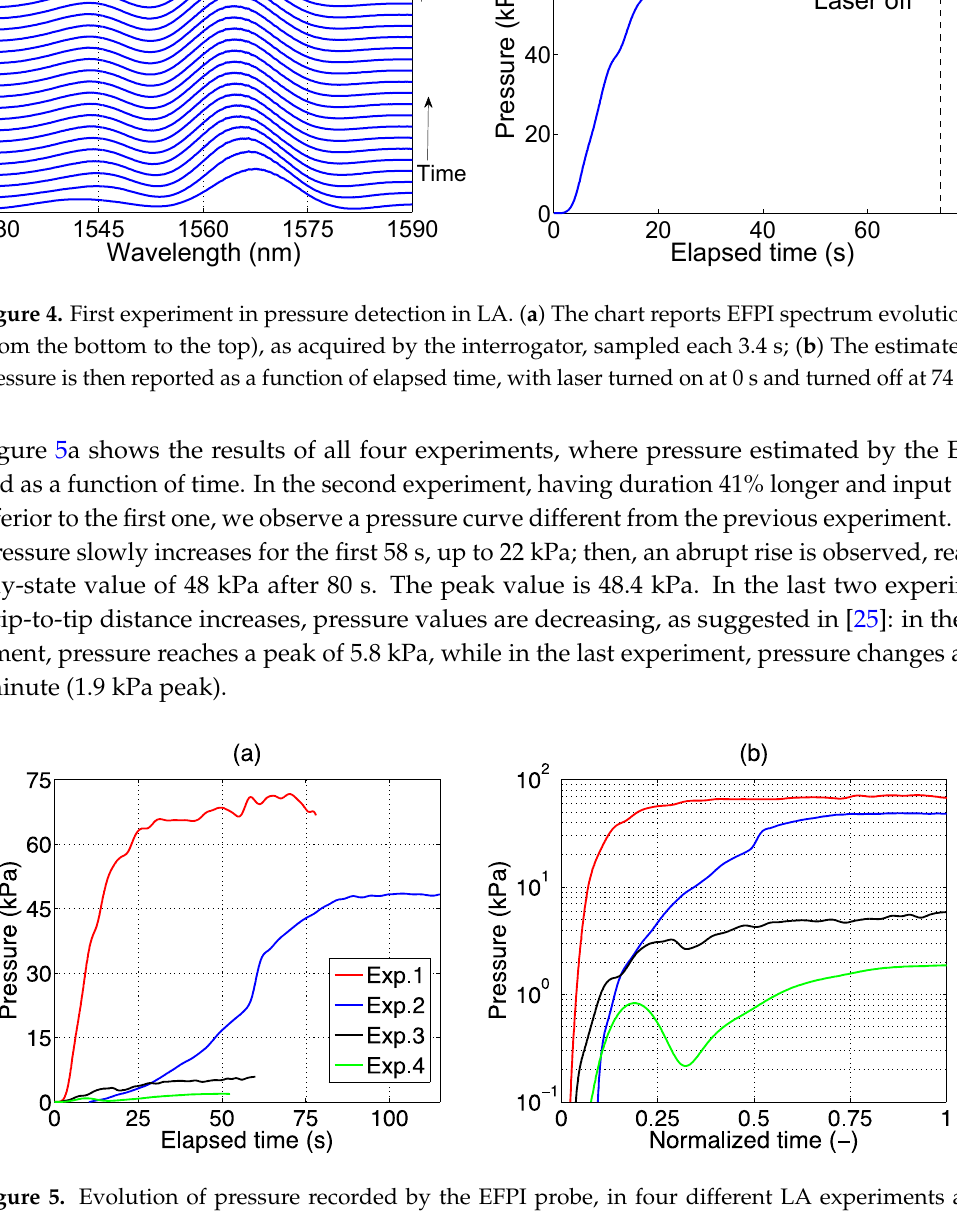
Figure 5. Evolution of pressure recorded by the EFPI probe, in four different LA experiments as outlined in Table 1. ( a ) Pressure chart for each experiment, reported from the start of the procedure to the final stage; ( b ) Pressure is reported, in logarithmic units, as a function of time, normalized between the values of 0 (laser on) and 1 (laser off).